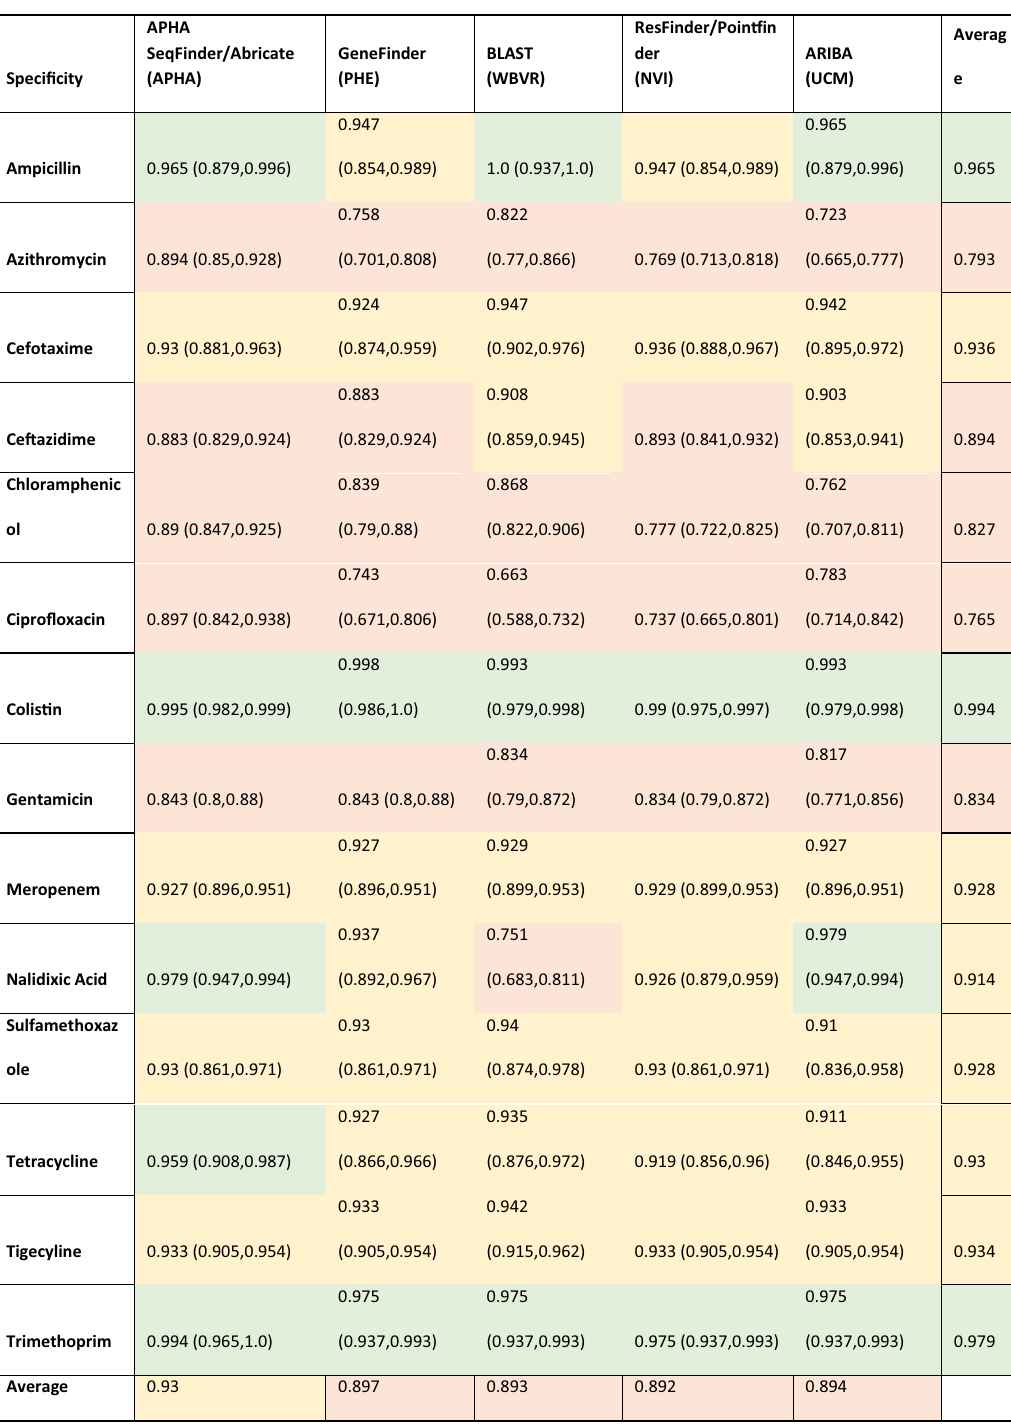
Table 3. Estimated sensitivity and specificity for each pipeline for each antimicrobial. The sensitivity (A), specificity (B) values and their 95% confidence intervals (values between brackets) for each pipeline and each antibiotic, with the overall average per pipeline also provided. Cells with values greater than or equal to 0.95 have a green background, between 0.90 and 0.49 orange have background, and less than 0.9 have a red background. The name of the institute that ran the pipeline is given within brackets. *The average values did not include sensitivity for